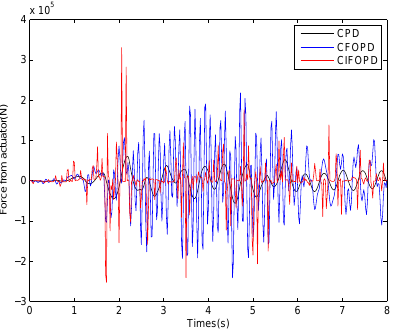
Figure 7. Forces output generated by the actuators under the action of the CPD, CFOPID, and CIFOPID